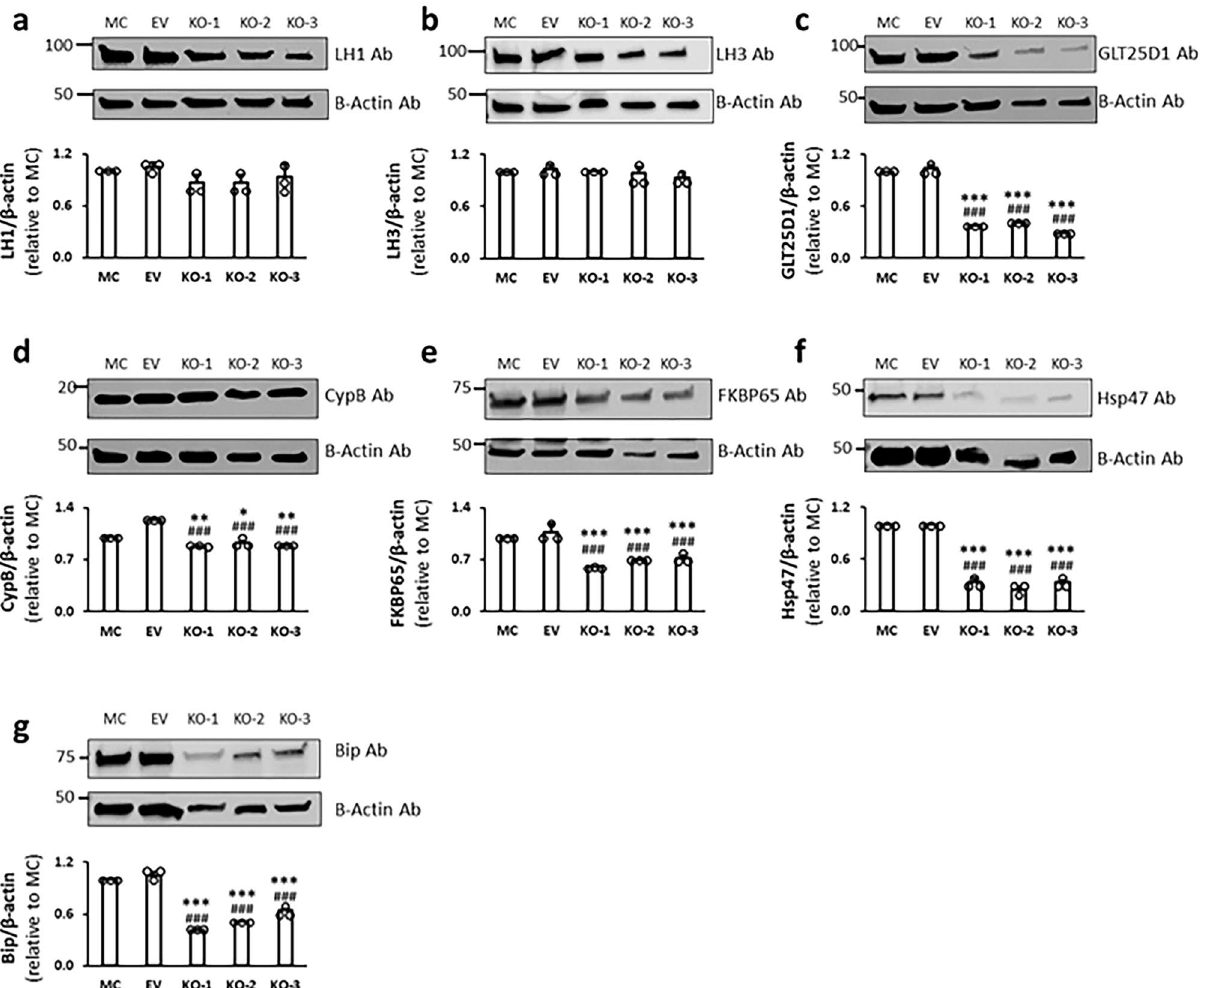
Figure 2. Western blot analysis for lysine modifying enzymes and chaperone complex components in cell lysates obtained from MC, EV, and KO clones. The protein levels were assessed by their immunoreactivities with the respective antibodies (Ab) relative to that of β-actin and were then shown as the change relative to LH2 expression levels in MC as 1.0. ( a ) LH1, ( b ) LH3, ( c ) GLT25D1, ( d ) CypB, ( e ) Fkbp65, ( f ) Hsp47, ( g ) Bip. Values represent mean ± S.D. (n = 3) from three independent experiments. Statistical differences were determined by the method described above (Fig. 1 legend). * p < 0.05, ** p < 0.01, and *** p < 0.001 between MC and KO; # p < 0.05, ## p < 0.01, and ### p < 0.001 between EV and KO, respectively. Original blots are presented in Supplementary Fig. S3. LH lysyl hydroxylase, GLT25D1 glycosyltransferase 25 domain containing 1, CypB cyclophilin B, FKBP65 FK506-binding protein 65, Hsp47 heat shock protein 47, Bip immunoglobulin heavy-